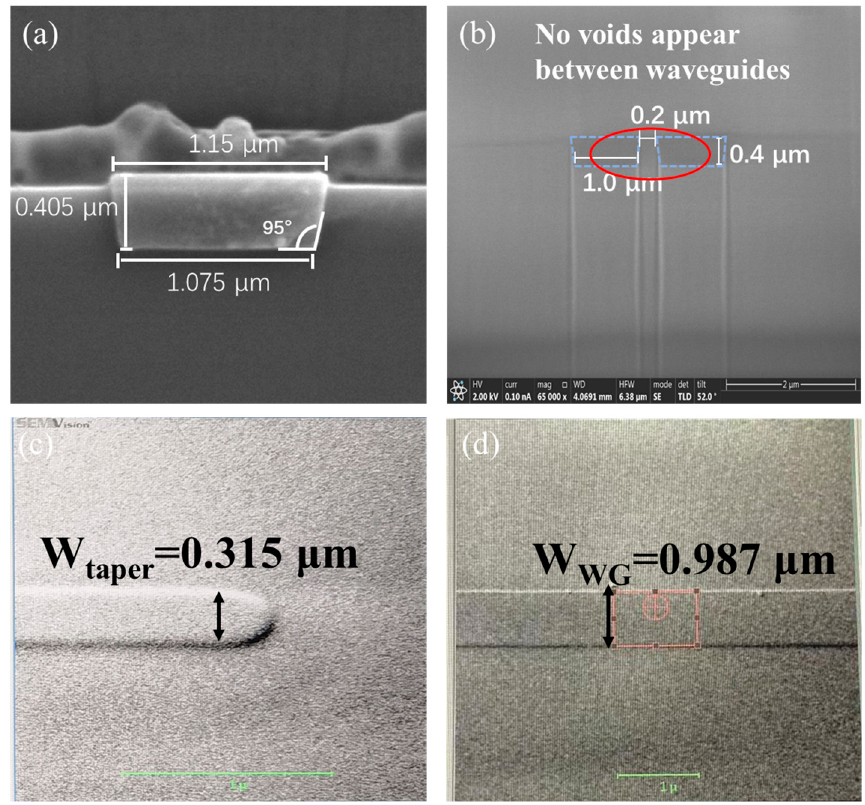
Figure 11. ( a ) XSEM image of the waveguide with measured dimensions, ( b ) XSEM image of two adjacent waveguides observed after cutting through with FIB, ( c ) SEM image of the tip after CMP, ( d ) SEM image of the waveguide after CMP.